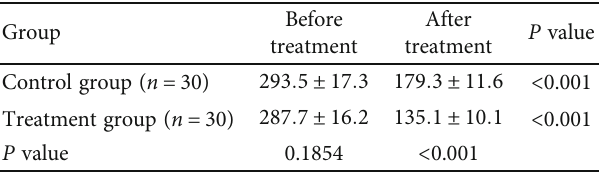
Before After P value treatment treatment